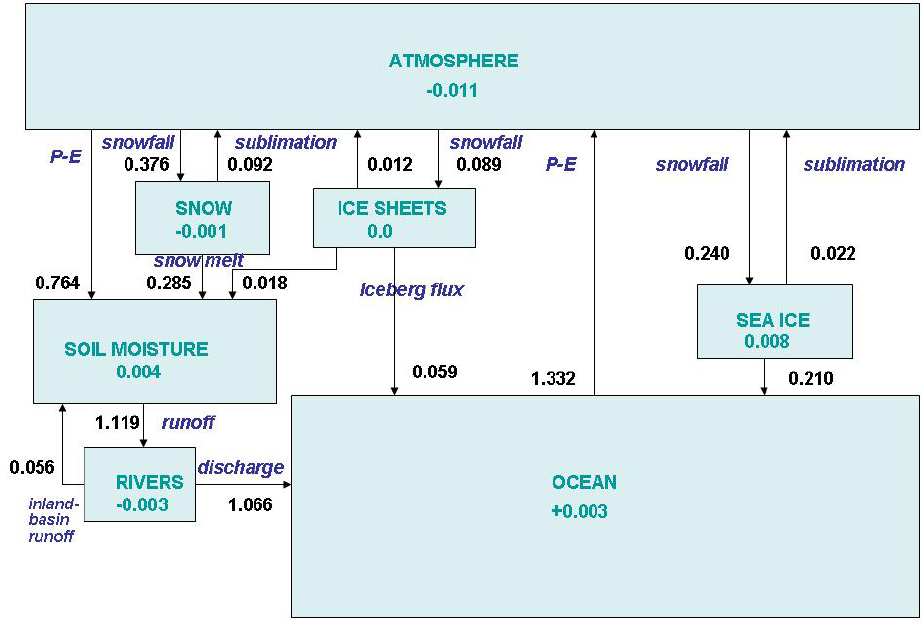
Fig. 1. Freshwater fluxes in HadGEM2 in Sv (10 6 m 3 s − 1 ) averaged over 10 yr of the model control run (pre-industrial conditions). Values inside the boxes are the differences between the flow in and out of each